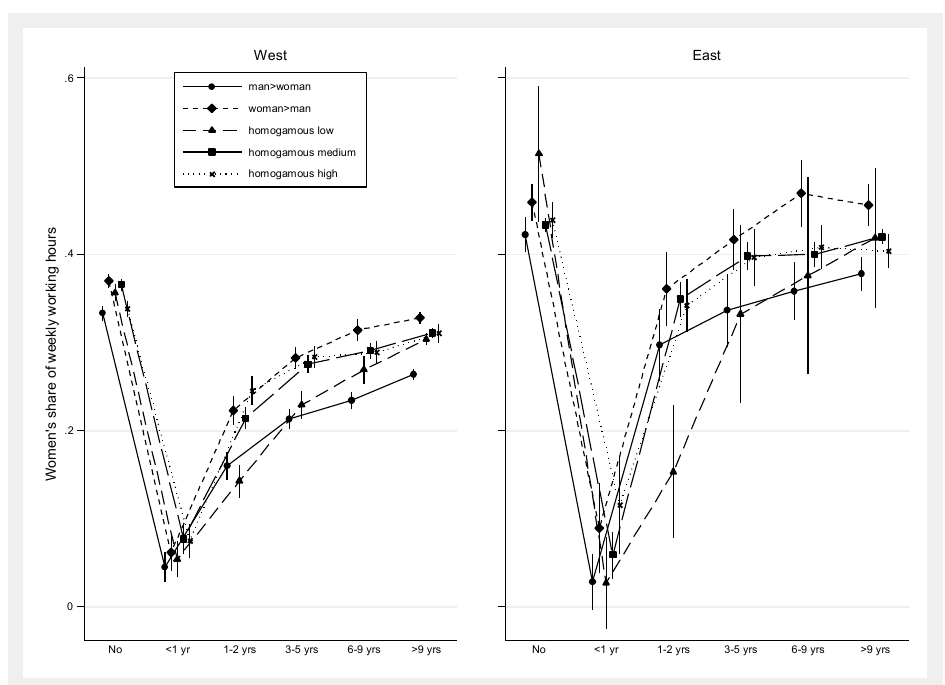
Figure 2 : Adjusted predictions for women’s proportion of weekly working hours, by relative education, presence of children/age of the youngest child and